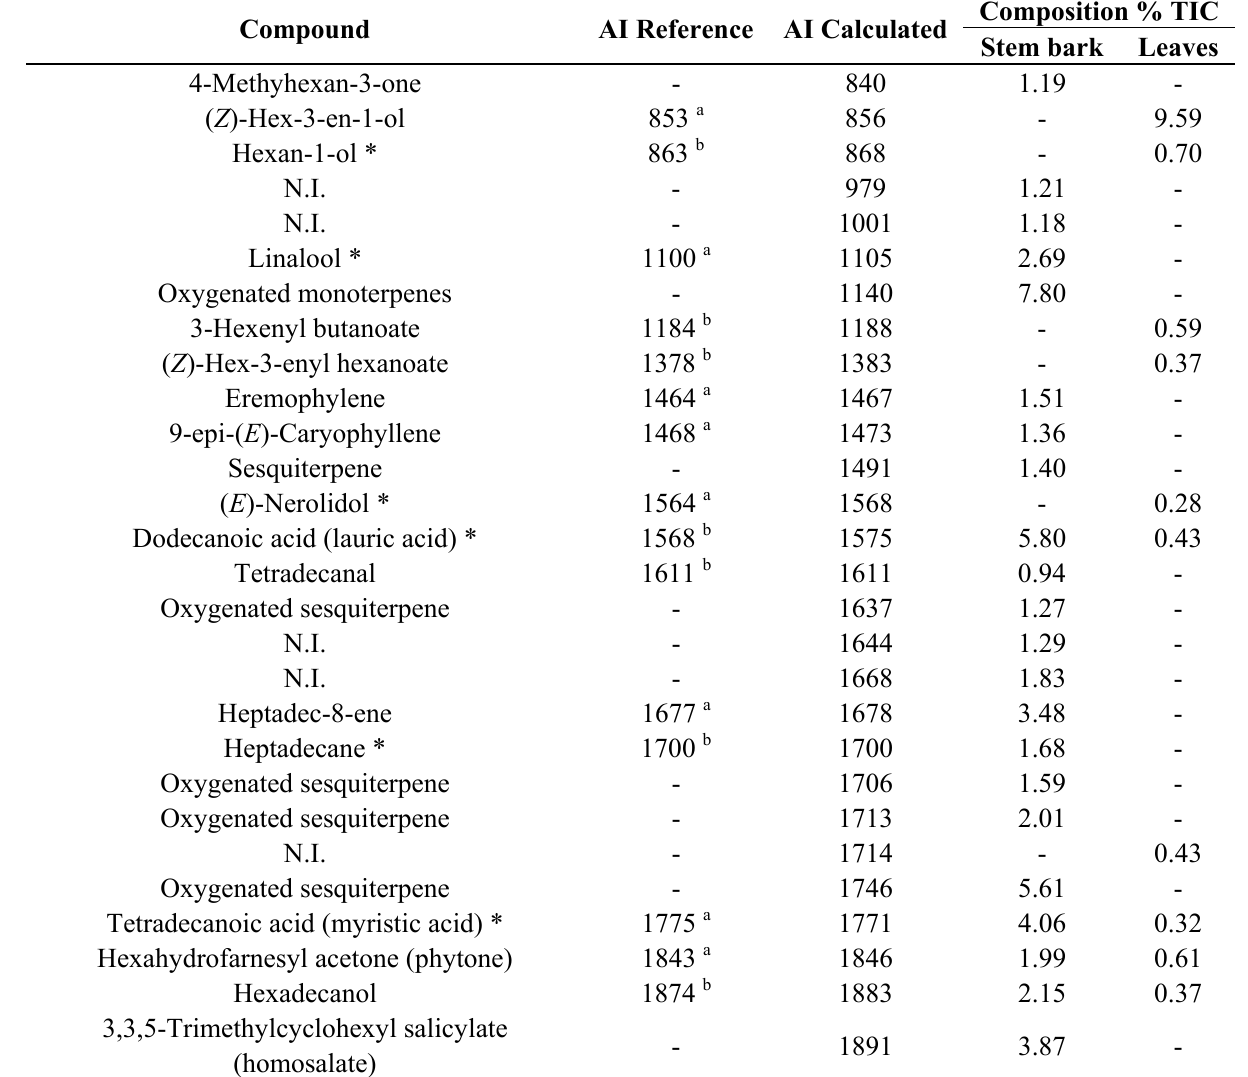
Table 3. Chemical composition of the essential oil from the stem bark and leaves of I. laurina in the rainy